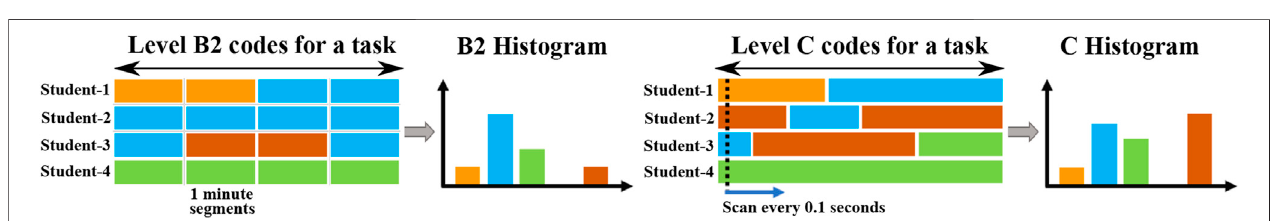
FIGURE 5 | Histogram feature generation for Level B2 and Level C. Different colors indicate different codes assigned to each segment. A B2 histogram was generatedforeachtaskbycompilingoverallthecodes,fromallthestudentsinthegroup.Similarly,levelChistogramwasgeneratedbycompilingallthecodes,sampled at every 0.1 seconds over the duration of the task. This illustration was fi rst described in (Som et al., 2020).